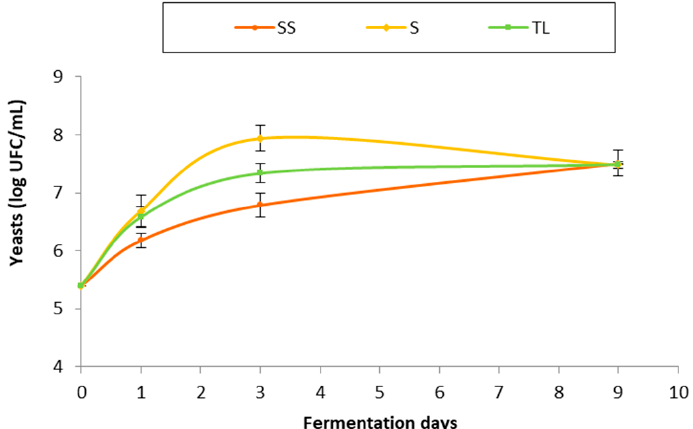
Figure 2. Yeast population (log CFU/mL) throughout AF in the different inoculation strategies (SS: spontaneous sulfite, S: spontaneous without SO 2 , TL: inoculation with T. delbrueckii / L. thermotolerans at vatting without SO 2 ).